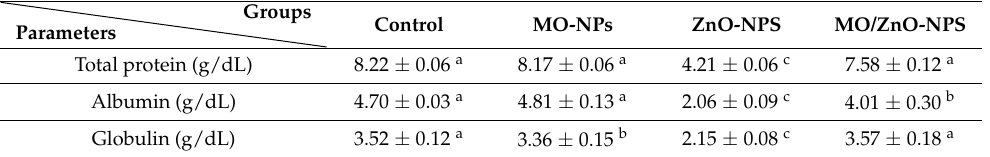
Table 4. Changes in total proteins (mean ± SD) of Nile tilapia , O. niloticus exposed to ZnO-NPs with MO leaves nanoparticles administration for 2